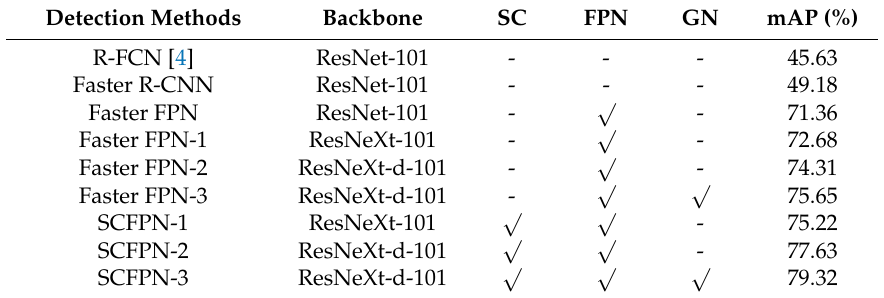
Table 3. Comparison of the mean average precision (mAP) results. SC: scene-contextual framework; FPN: feature pyramid network; GN: group normalization layer; R-CNN: region-based convolutional neural network. 101 means the model with 101 layers. The bold result is the best performance value.